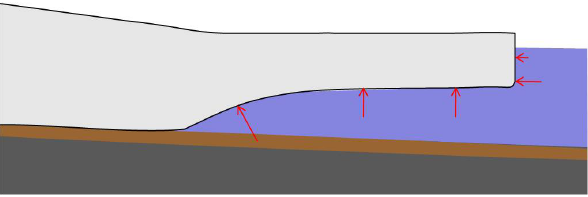
Fig. 3. Schematic showing an ice stream flowing into the ocean and forming an ice shelf. The pressure from the ocean acting on the ice is depicted as red arrows. Tides cause temporal changes in the oceanic forces and can lead to changes in ice-stream flow. Note that the figure is only a schematic and that in model runs the actual detailed model geometry is not as shown. Information on model geometry for each numerical experiment is given in the